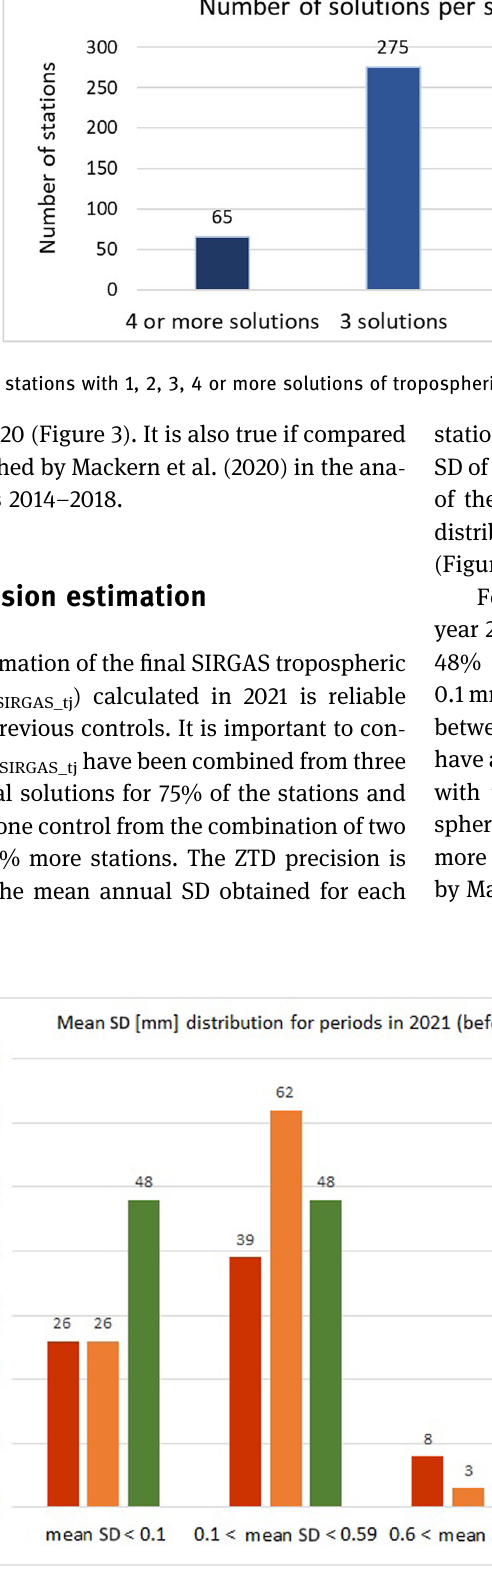
Figure 12: ZTD SIRGAS_tj internal precision. Mean SD distribution, for the 2021 periods before, during and after improvement year